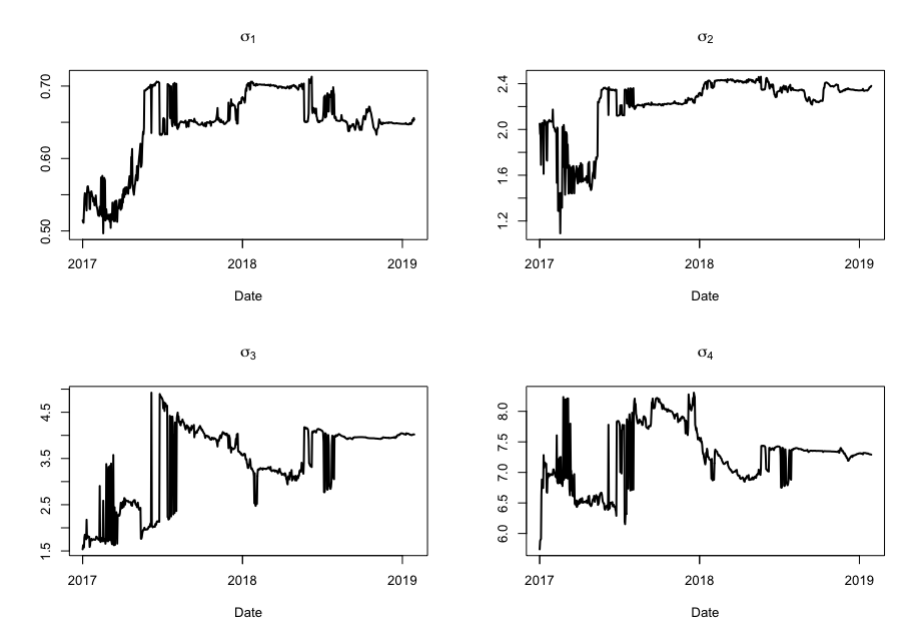
Figure 4. Expanding window: state-dependent means and volatilities for the homogeneous four-state normal-HMM on BTC/USD daily log returns.